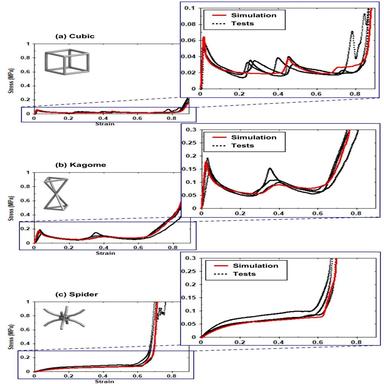
Evaluation of quasi–static compressive behaviour of the FE lattice structures (set 1): a) cubic, b) kagome, and c) spider.